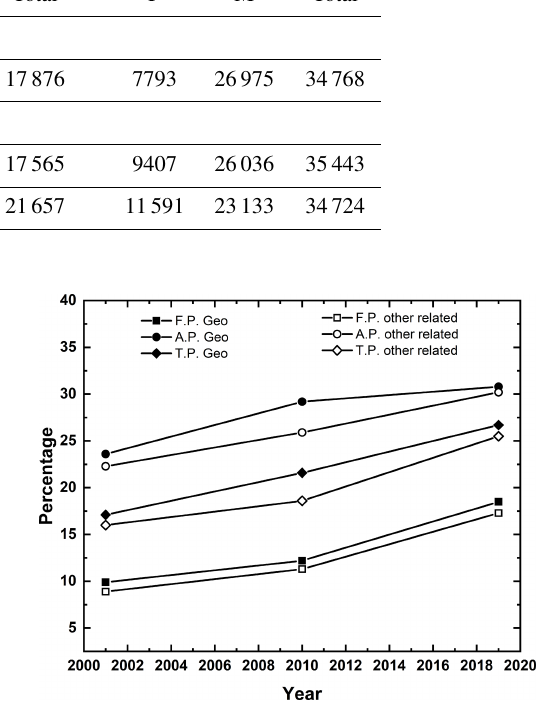
Figure 8. Comparison between percentages of female